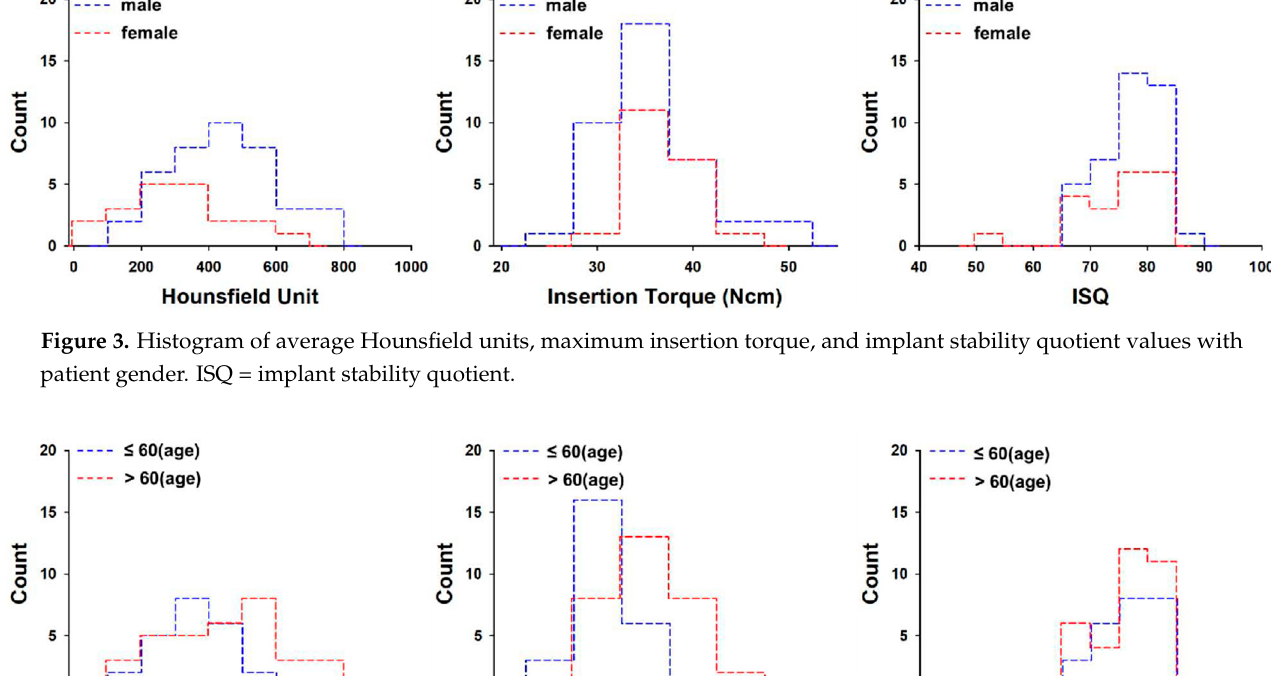
Figure 3. Histogram of average Hounsfield units, maximum insertion torque, and implant stability quotient values with patient gender. ISQ = implant stability quotient.